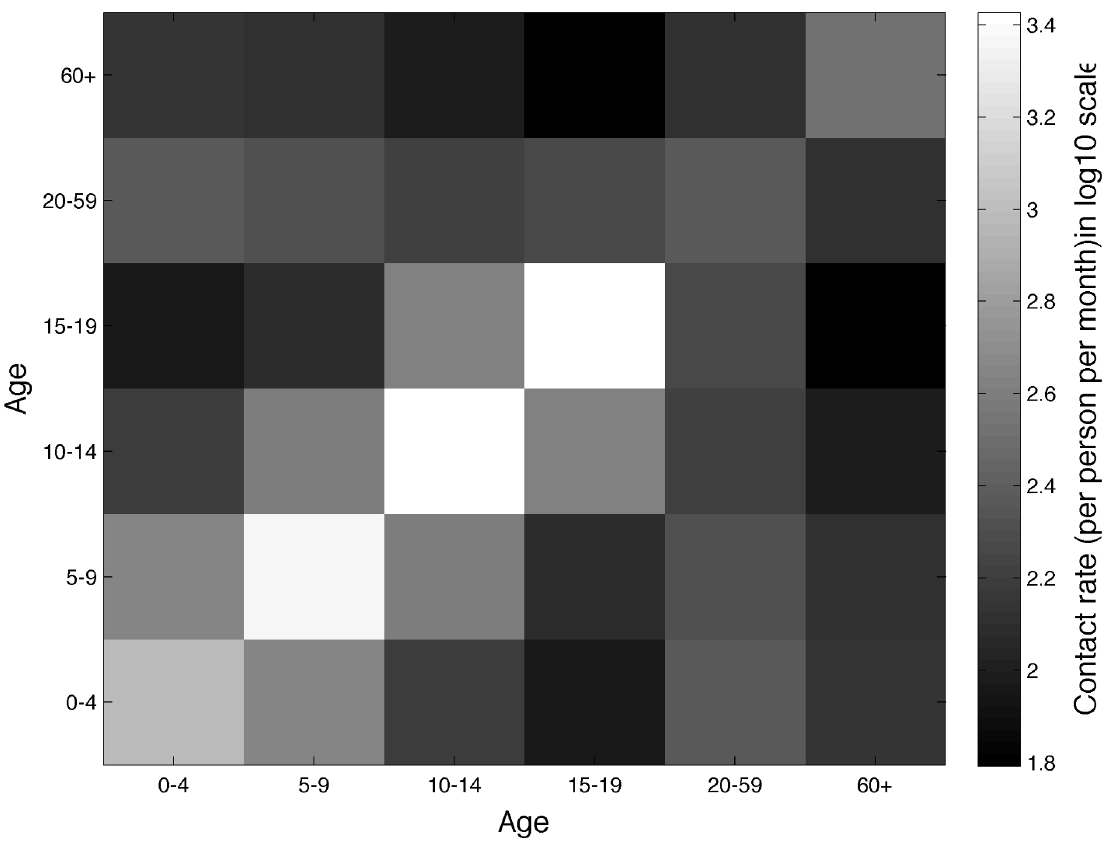
Figure 2. Monthly contact rates among age groups ( w a a ). Calculated from survey data on physical contacts from Mossong et al. [25].